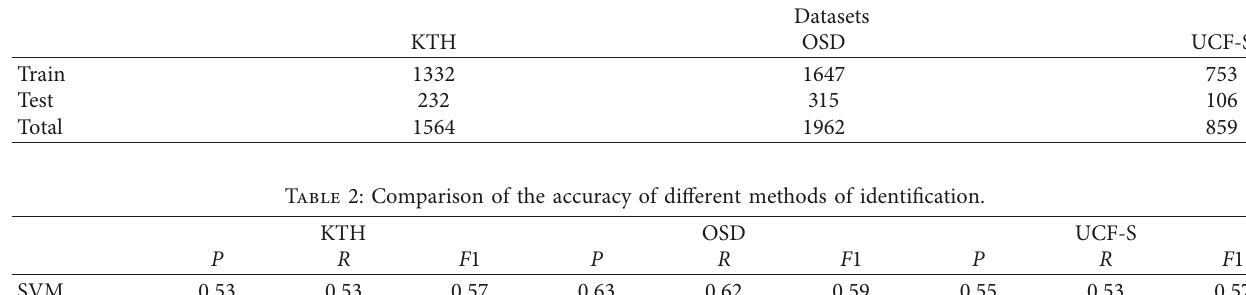
Table 1: Number of training sets and test sets.